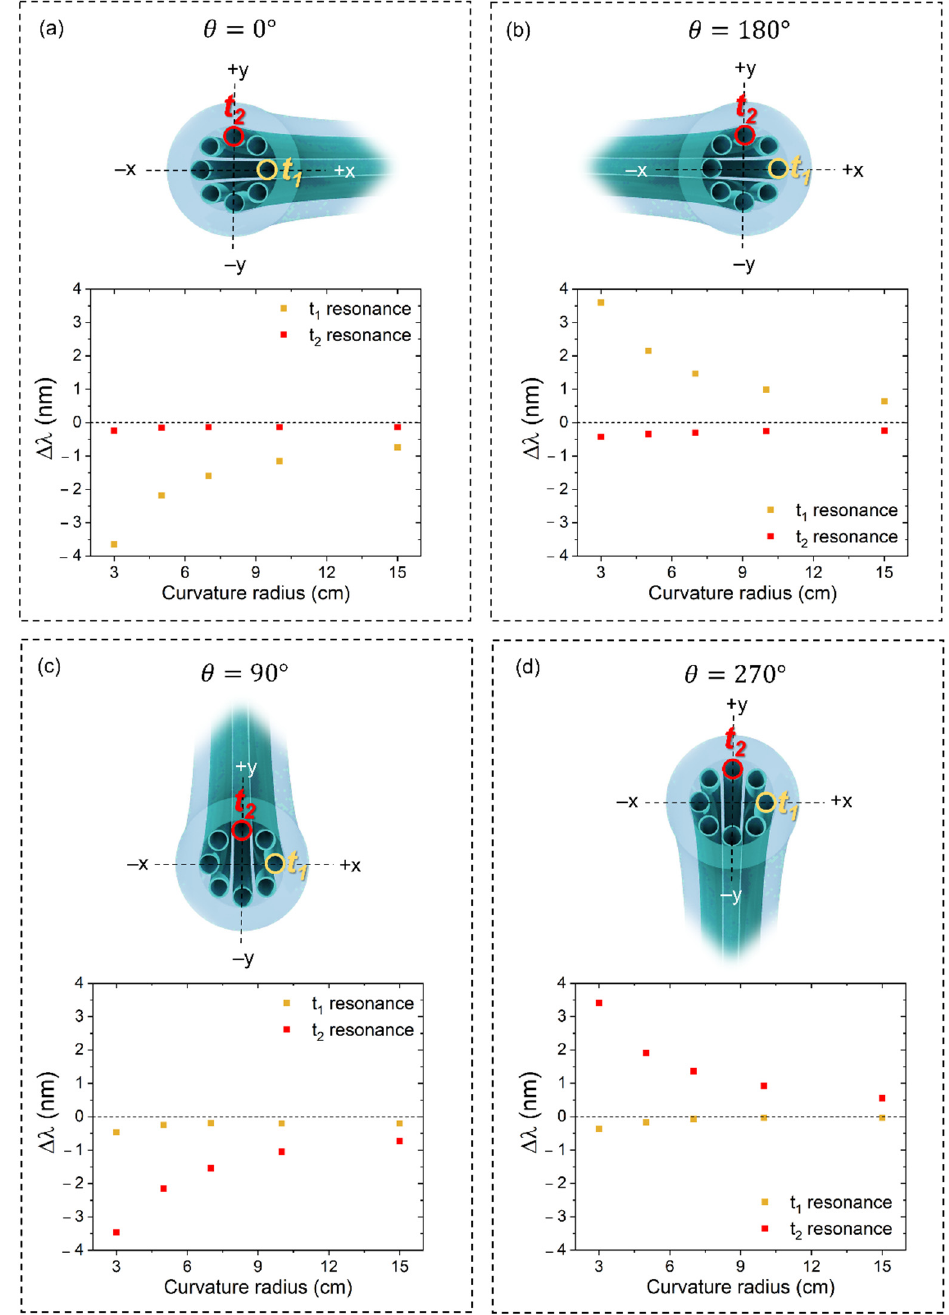
Figure 2. Simulated wavelength shifts ( Δλ ) associated with t 1 and t 2 resonances as a function of the curvature radius for ( a ) θ = 0°, ( b ) θ = 90°, ( c ) θ = 180°, and ( d ) θ = 270°.